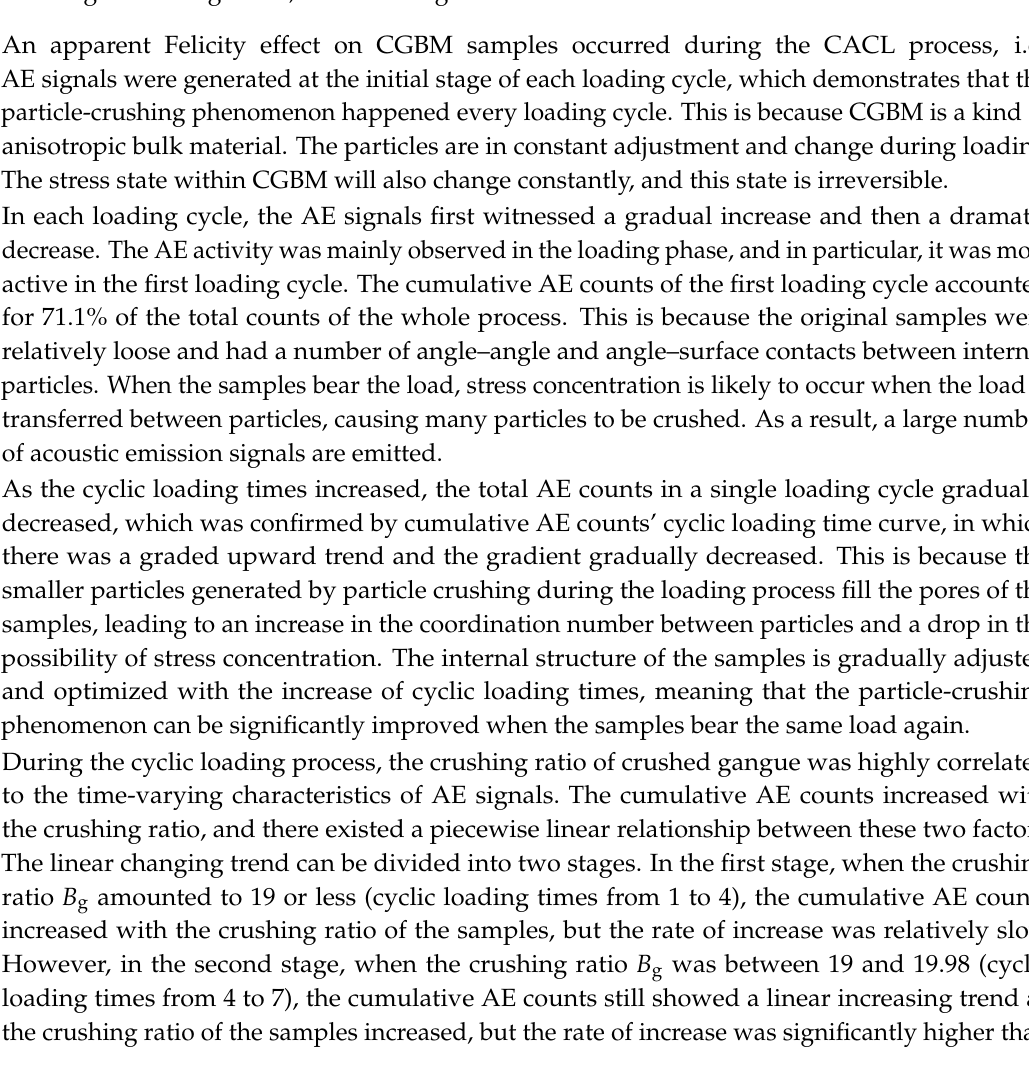
Figure 11. The relationship between cumulative AE counts and crushing ratio.